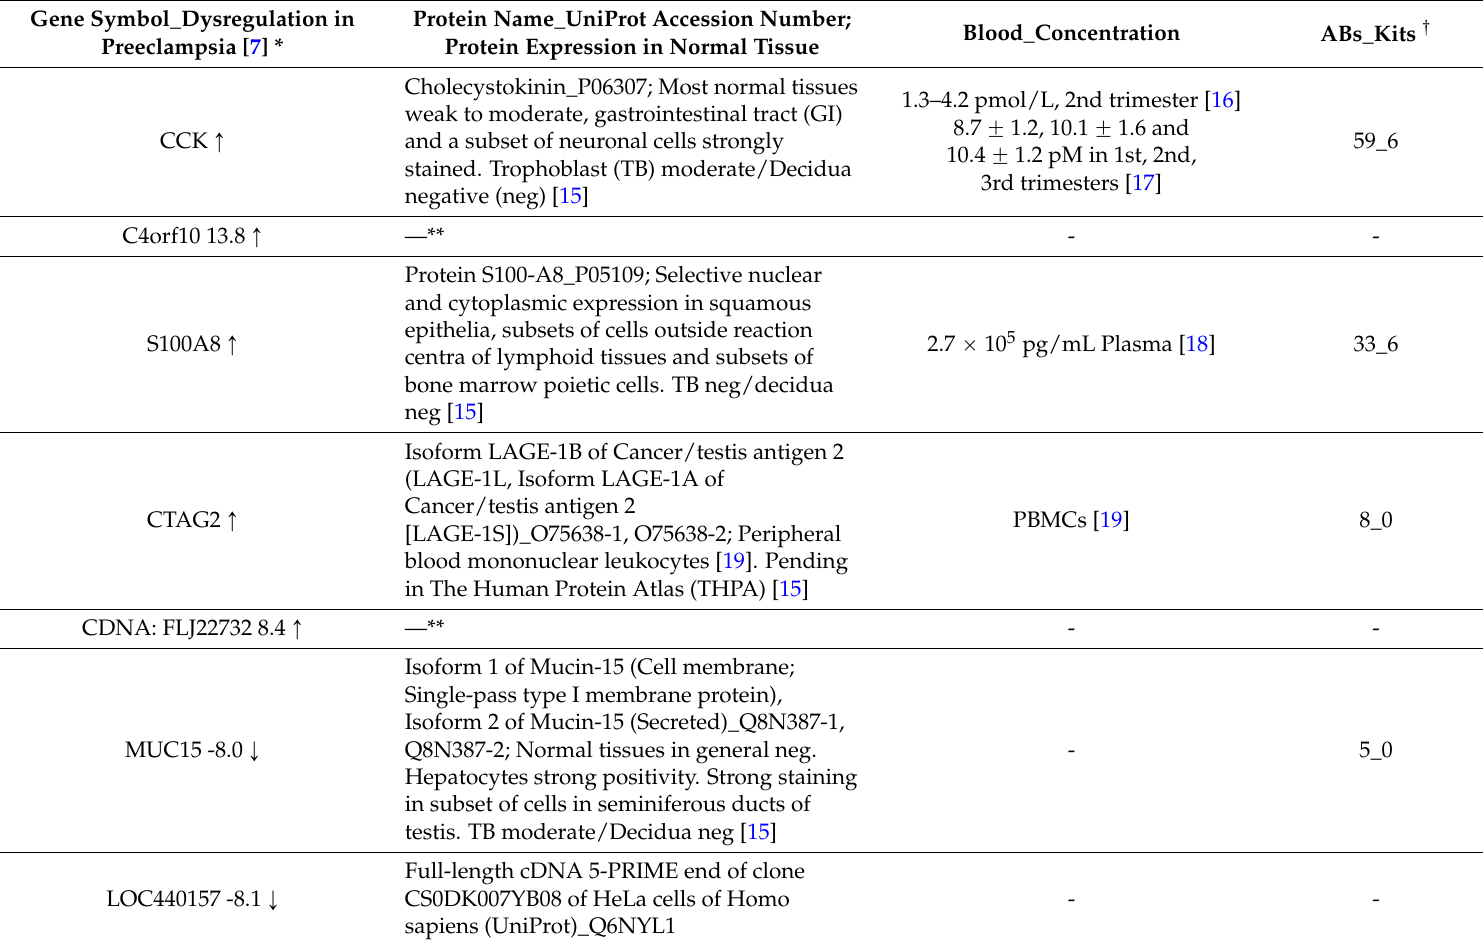
Table 1. Proteins encoded by preeclampsia candidate genes